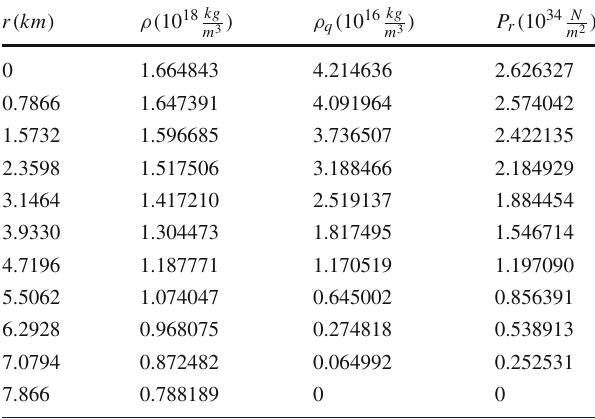
withoutquintessence,whichwas B g = 99 . 7207866 Mev / fm 3